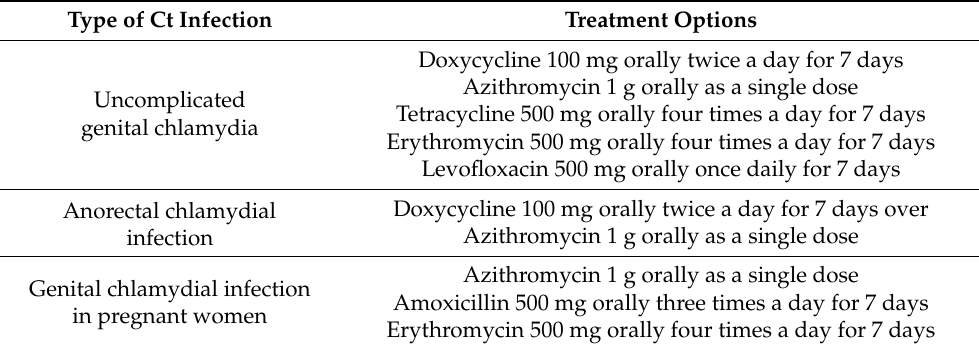
Table 3. Ct infection treatment options following the guidelines